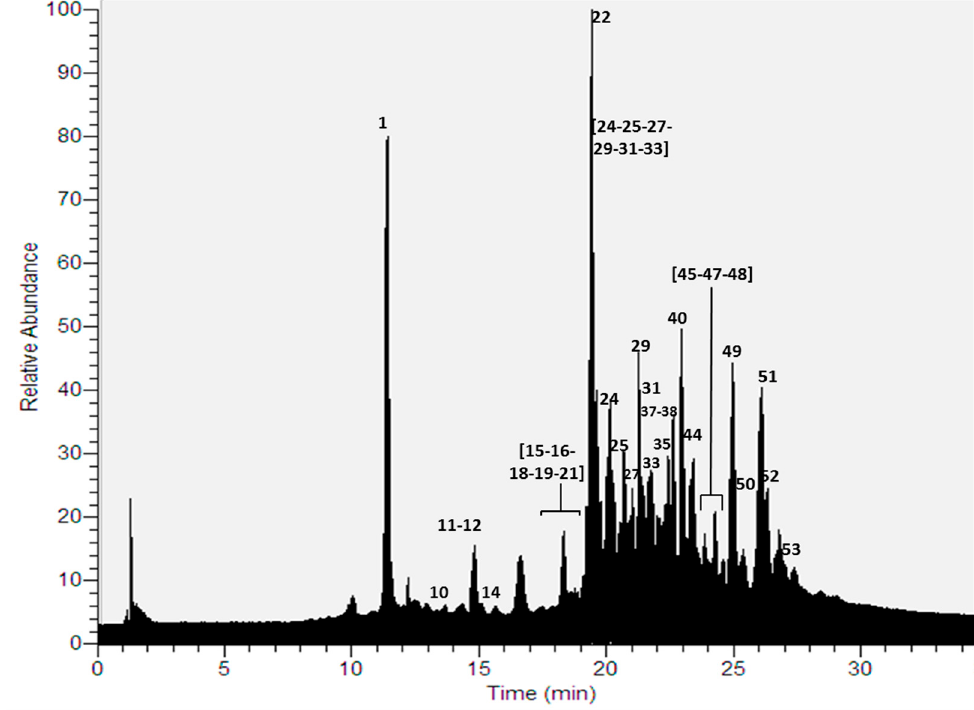
Figure 1. UHPLC Chromatogram of P. andinum .